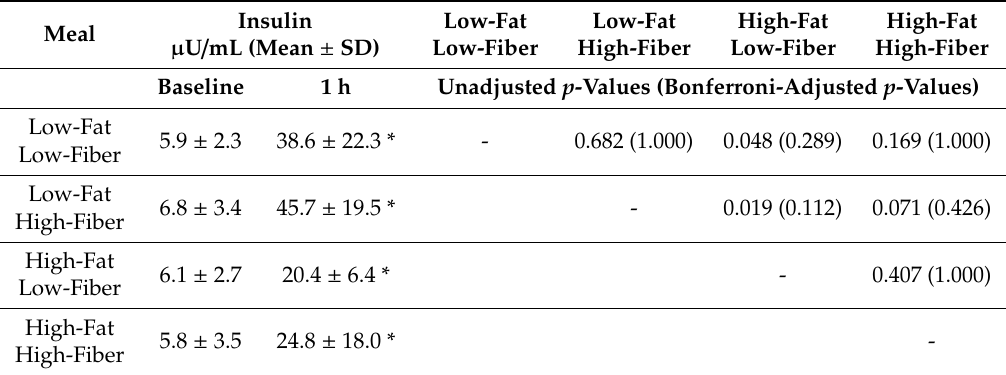
Figure 3. Plasma insulin concentrations over time in response to four meals. Dashed lines represent individual subject responses. Solid line represents mean response for all subjects. See text and Table 5 for statistical comparisons between meals. Table 5. Plasma insulin responses 1 h postprandial: comparison between meals.